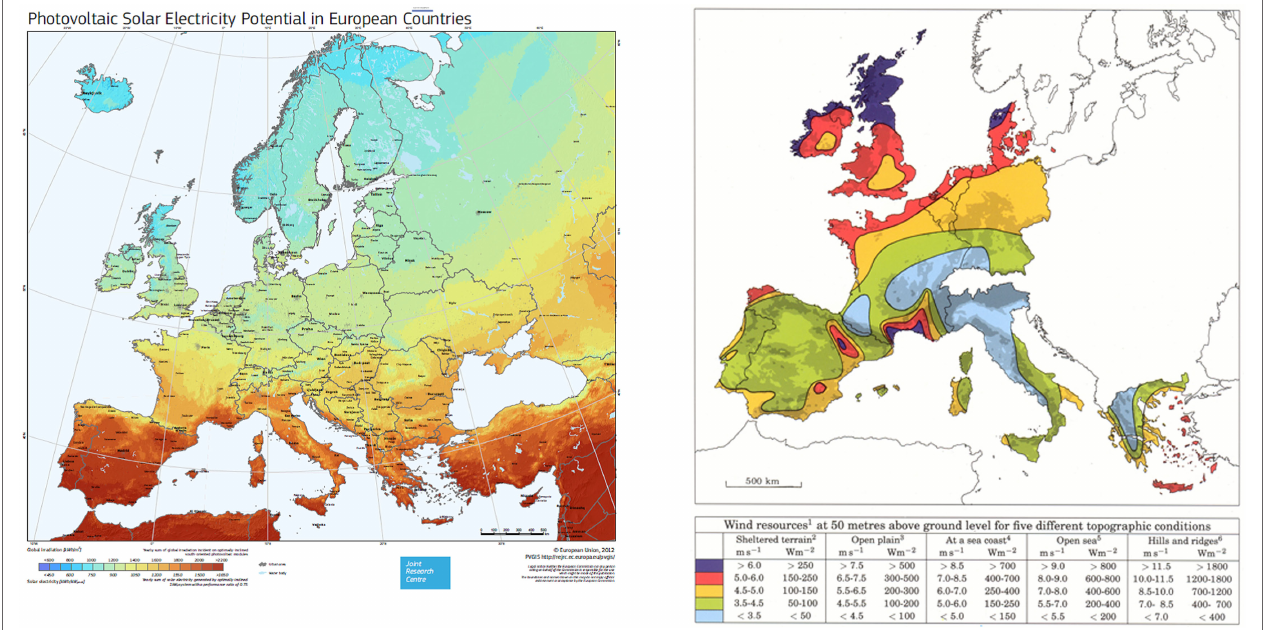
FIGURE 2 | (Left) solar map of Europe (right) wind map of Europe 1 (Huld and Pinedo-Pascua, 2012) .